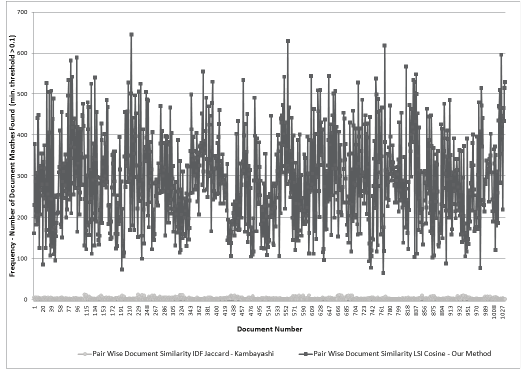
Fig. 11. Pair-wise document similarity TF-IDF Jaccard vs. LSI